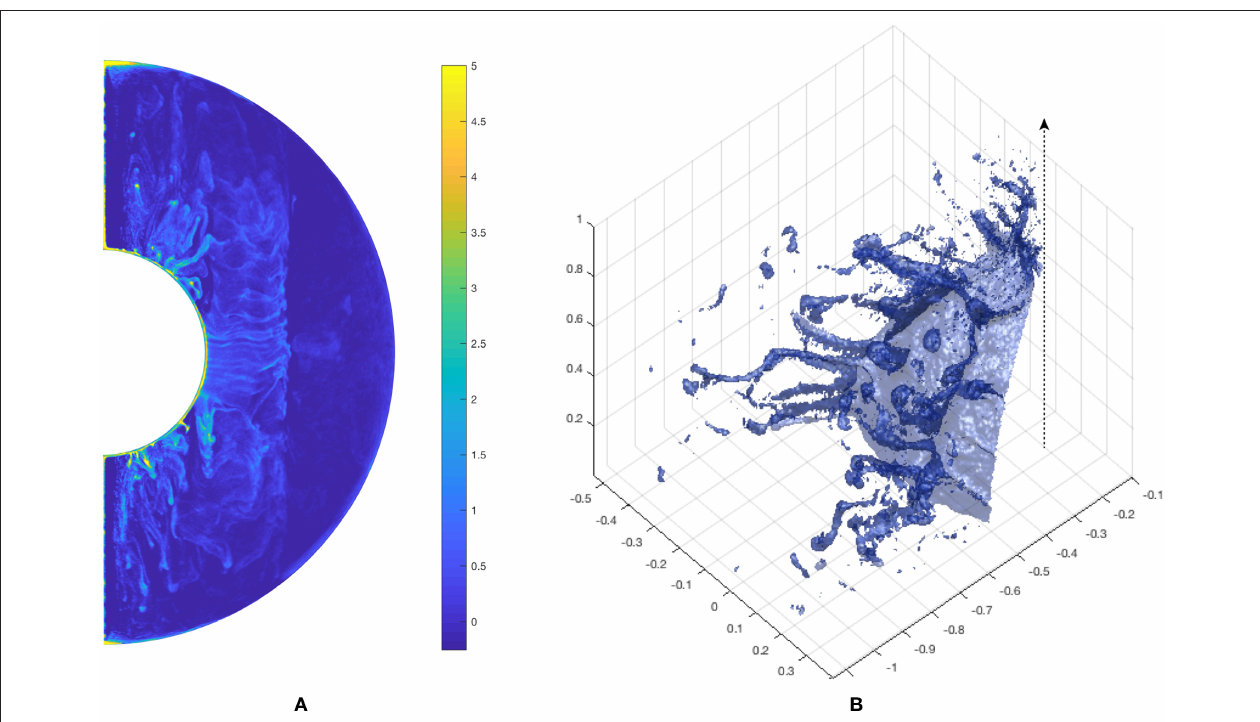
FIGURE 2 | (A) Azimuthal section of the compositional field corresponding to case 8 shortly after the destabilization of the initial bottom light layer. To better visualize the curtain shape, an azimuthal average was performed over a smaller interval 1φ 0.01 around the longitude φ 0 centered on a chemical “curtain.” (B) Isosurface = corresponding to a constant composition for case 3. The vertical dotted line shows the position and orientation of the rotation